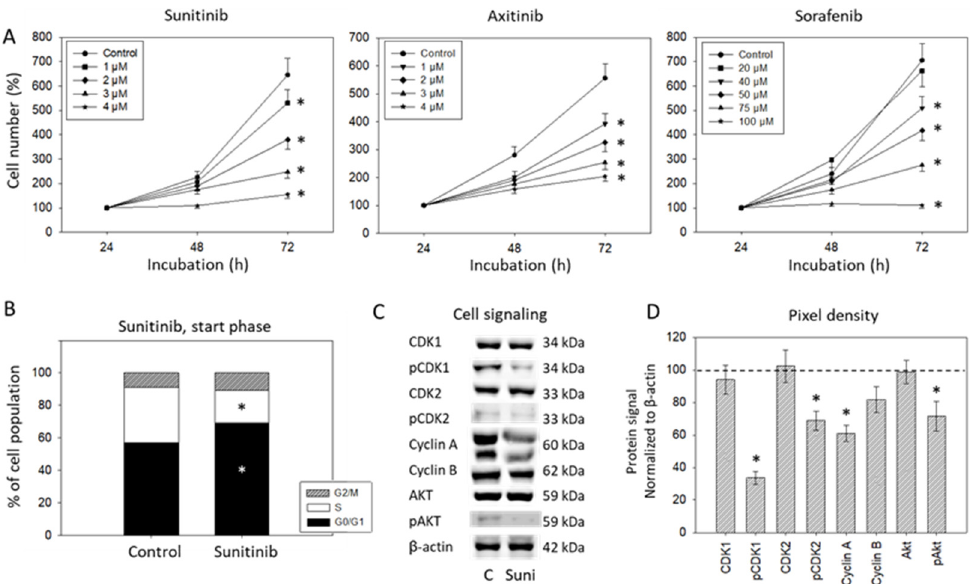
Figure 2. ( A ) Dose-response analysis. HUVECs were incubated with different concentrations of sunitinib, axitinib or sorafenib, and cell number was evaluated after 24 (100%), 48 and 72 h by MTT assay. Means and standard deviation are indicated, n = 3, * = p ≤ 0.05. ( B ) Influence of 2 µM sunitinib on G0/G1-, S- and G2/M-phases of the cell cycle in HUVEC after 24 h (n = 3). * indicates significant difference to untreated controls. ( C ) Protein profile of cell-cycle-regulating proteins after exposure to 2 µM sunitinib (Suni). Controls ( C ) were untreated (0 µM sunitinib). One representative of three separate experiments is shown. Each protein analysis was accompanied by a β -actin loading control. One representative internal control is shown. ( D ) The ratio of protein intensity/ β -actin intensity was calculated and expressed as a percentage of the controls, set to 100%. * indicates significant difference to controls, p ≤ 0.05. n = 3.